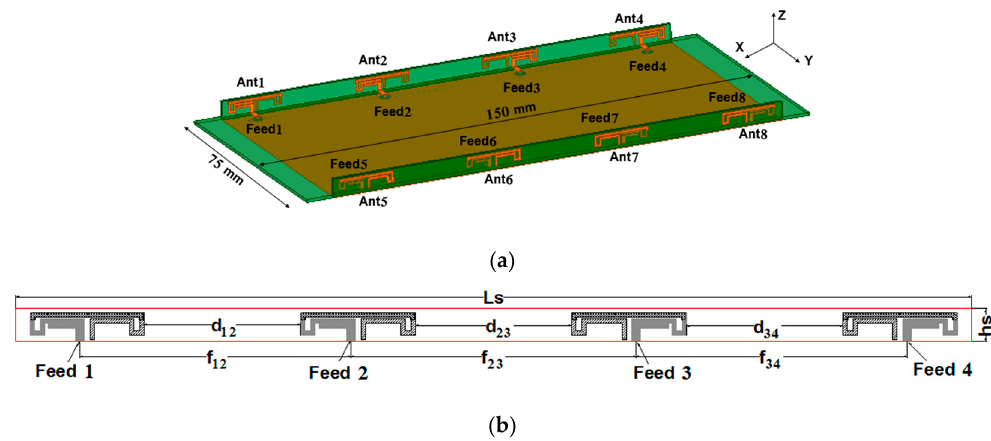
Figure 1. Perspective and side views of the proposed MIMO antenna array (unit: mm). ( a ) Perspective view. ( b ) Side view.